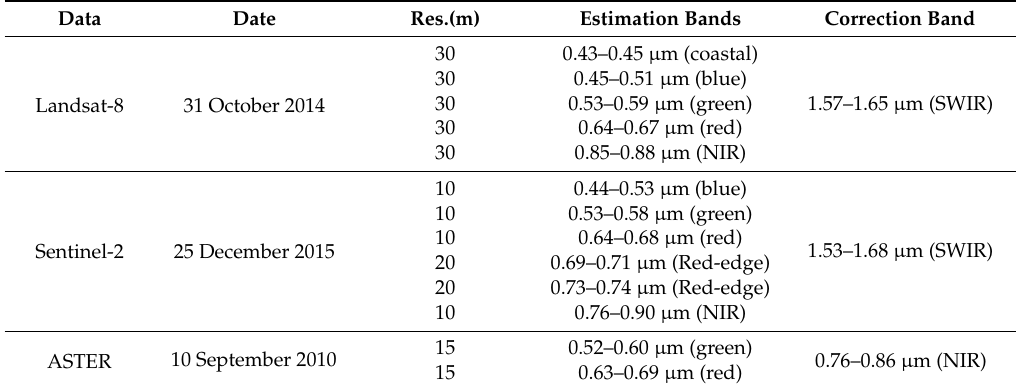
Figure 4. Case study 2 and 3: Study area, parts of the Iwate Prefecture and the Miyagi Prefecture, Japan. Table 1. Characteristics of data used.